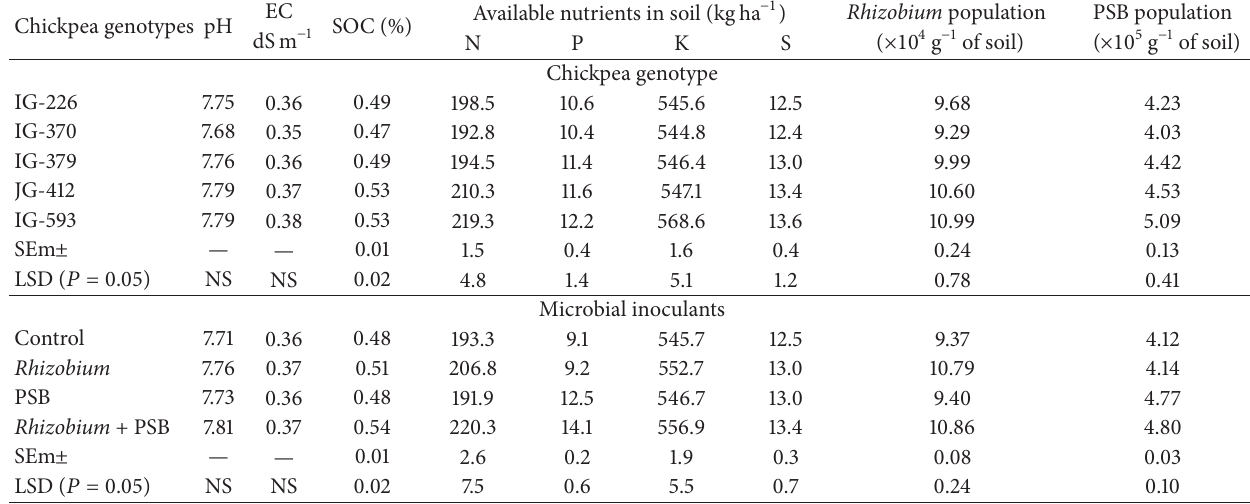
Table 4: Soil fertility as influenced by chickpea genotypes and microbial